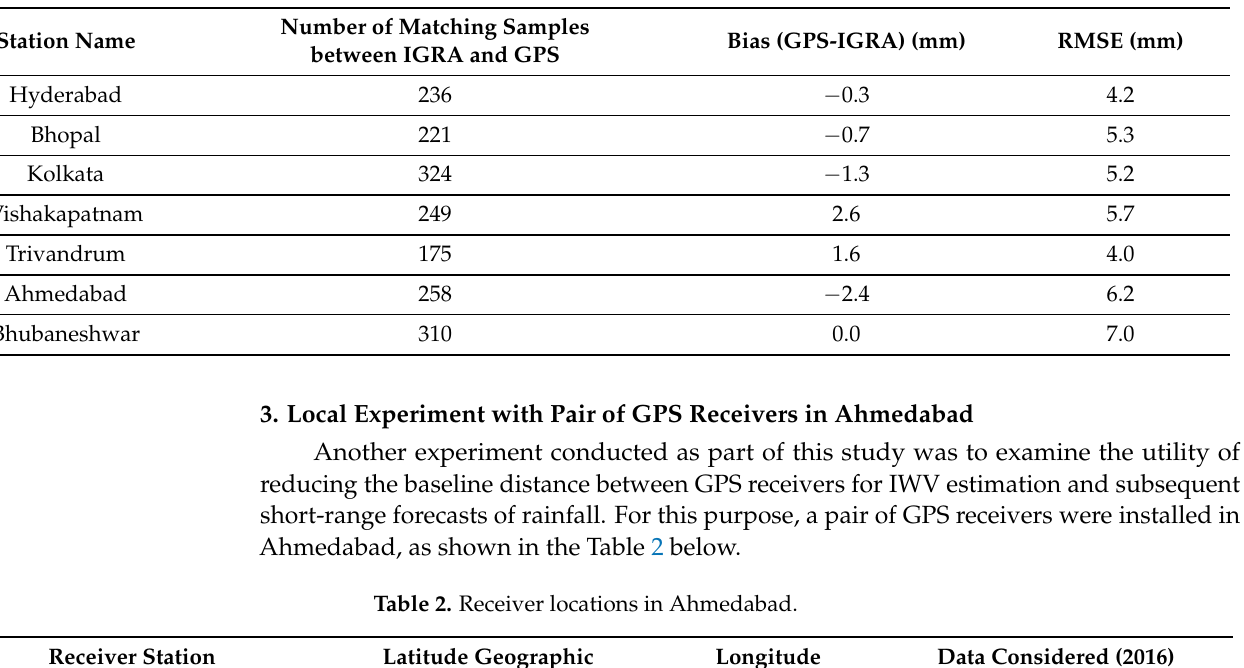
Table 1. Comparison of GPS-derived IWV with IGRA radiosonde data.